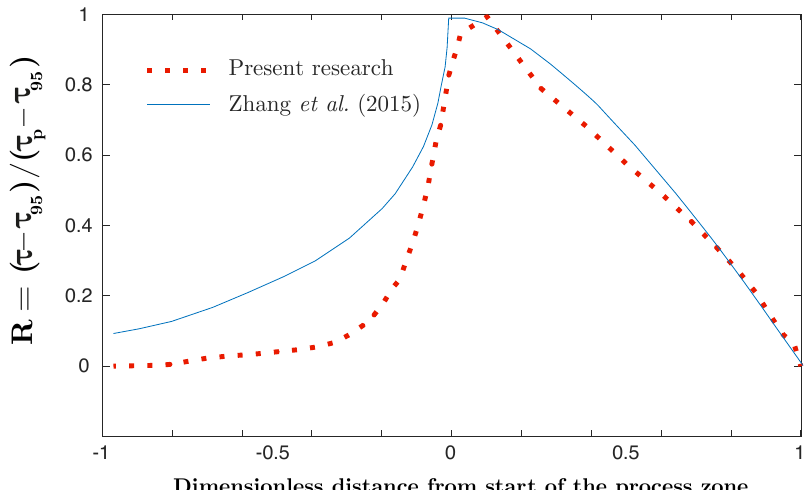
Figure 6. Comparison of the results of the dimensionless stress along the dimensionless distance between the proposed algorithm and the solution provided by Zhang et al.